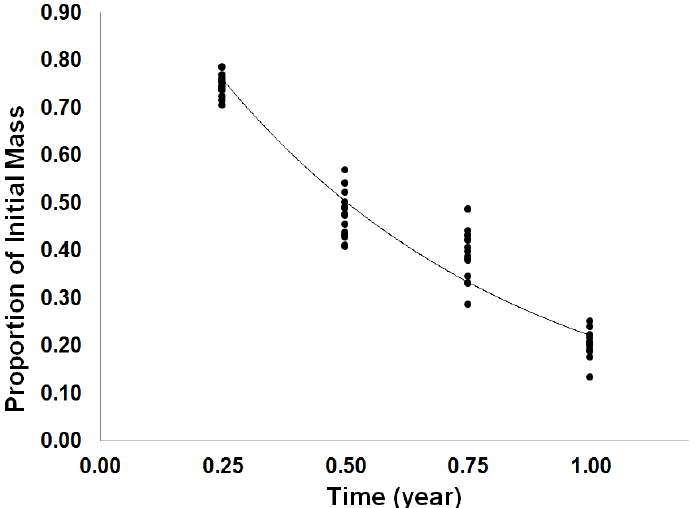
Figure 1. The proportion of initial mass remaining as a function of time in years for the simulated forest floor decomposition experiment. Data were pooled by treatment due to no difference in decomposition among treatments. Also shown is the exponential decay regression